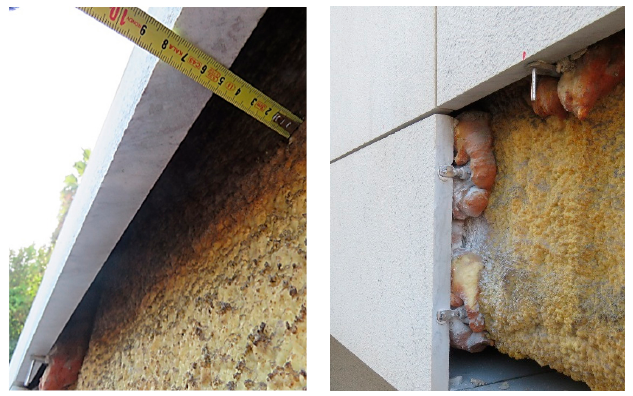
Figure 2. Detail view of cladding after removal of a stone slab (dowel anchorage system/fixing points).